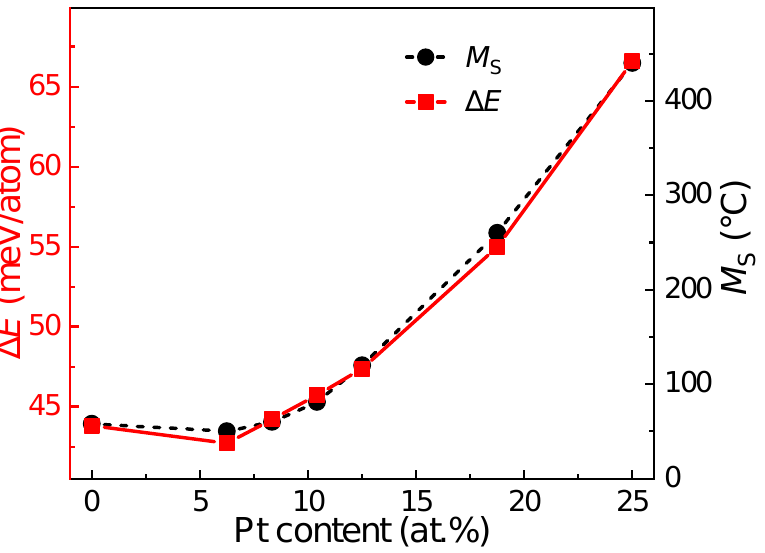
Figure 7. Compositional dependence of ∆ E and phase transformation start temperature ( M s ) of Ti 50 Ni 50 − x Pt x alloys. The data of M s refer to the right axis and those of ∆ E to the left axis. M s is cited from Ref.